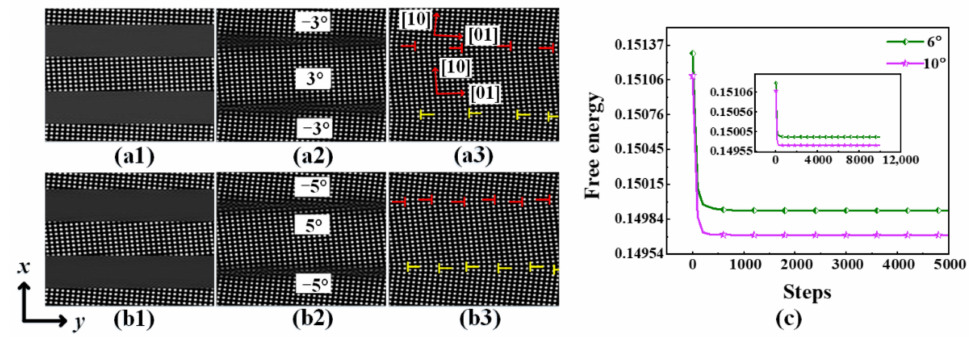
Figure 2. ( a – c ) are simulation diagrams and free energy curves of the grain solidification growth process with θ = 6 ◦ and θ = 10 ◦ , respectively. t ∗ = 100, t ∗ = 200, t ∗ =